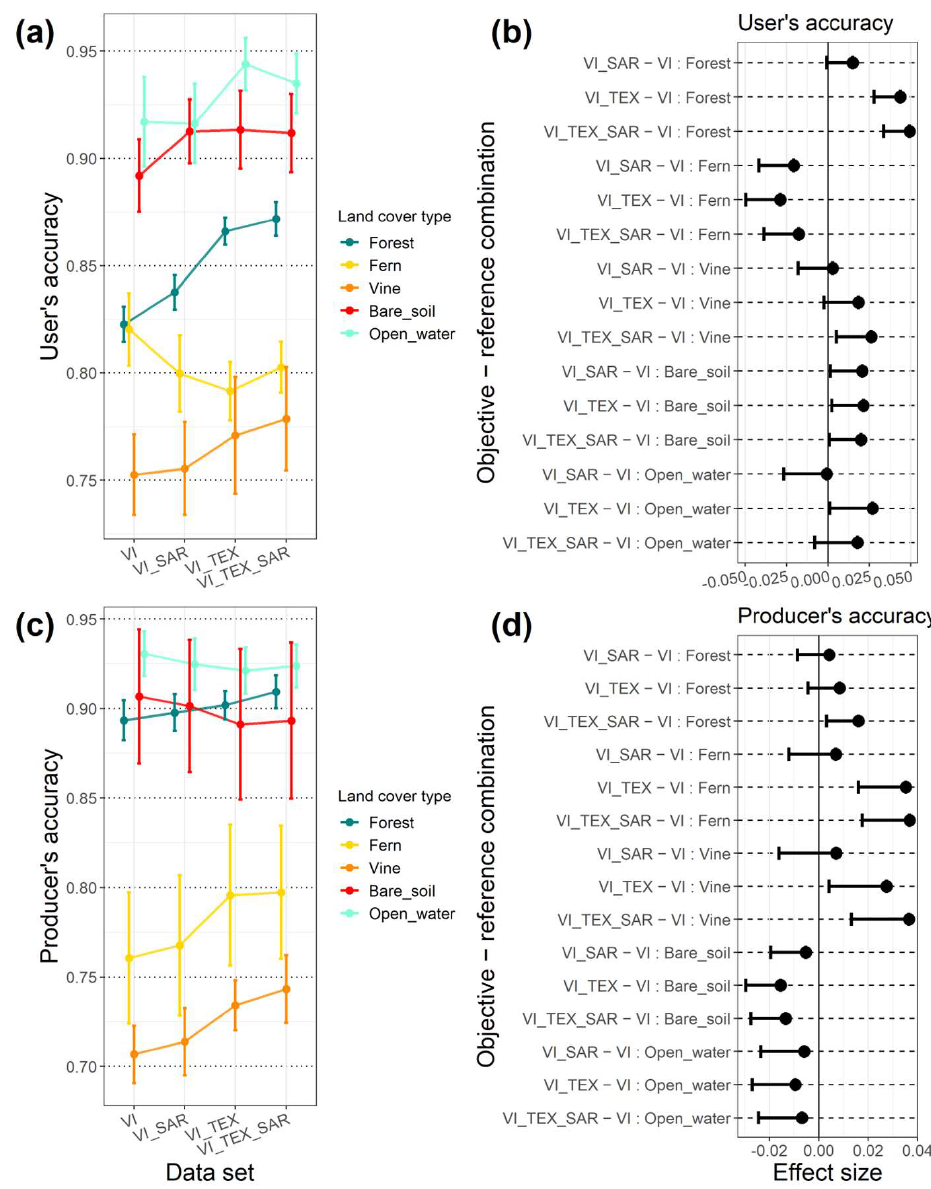
Figure 4. Comparison of the classification accuracy of each land-cover type among different data sets. Data sets are indicated with code names explained in Table 2. The interval plots of the user’s accuracy ( a ) and producer’s accuracy ( c ) are presented. Dots represent the mean value of each metric for each land-cover type, and the error bar represents the standard error ( n = 16). Green represents forest, yellow represents fern, orange represents vine, red represents bare soil, and blue represents open water class. The interval plots of the multiple comparisons (Dunnett’s test) with the linear mixed model of user’s accuracy ( b ) and producer’s accuracy ( d ) are also given. The Y-axis represents the combination of the objective and reference data set for each land-cover type; the former is the objective and the latter is the reference. Dots represent the effect size of the objective data set, compared to the reference data set, and the error bar represents the lower limit of the 95% confidence interval in the one-tailed test.